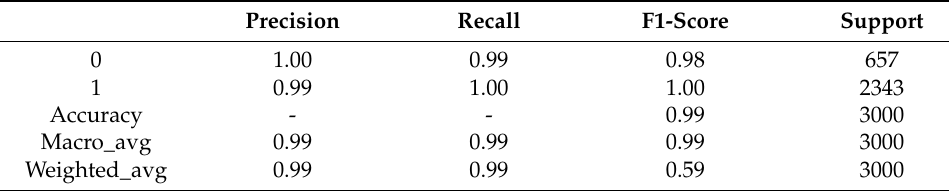
Table 2. Classification report for the proposed system (QCNN_BaOpt).